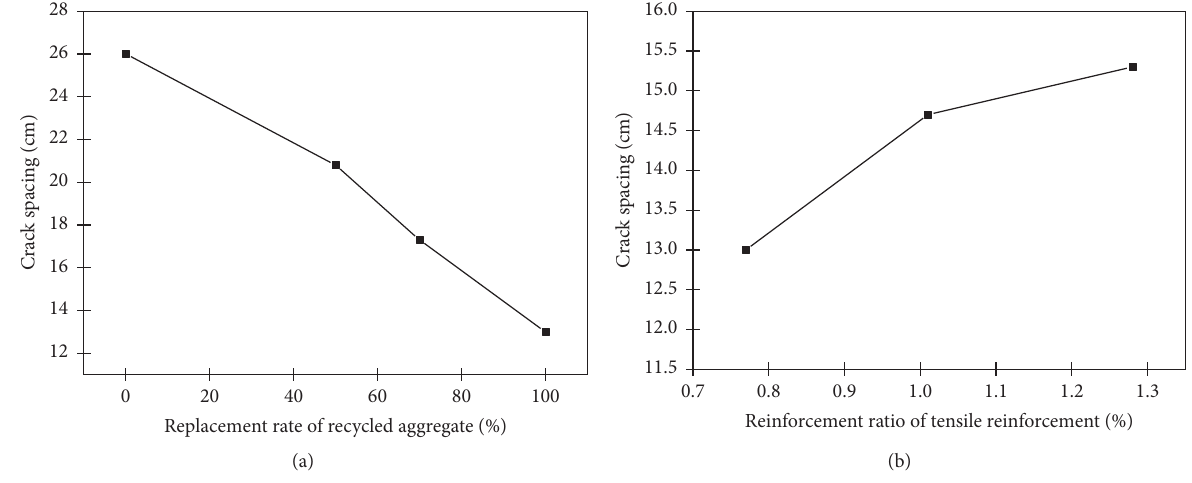
Figure 7: Crack development diagram of test beams. (a) NAC-0.77. (b) RAC-50-0.77. (c) RAC-70-0.77. (d) RAC-100-0.77. (e) RAC-100- 1.01. (f)